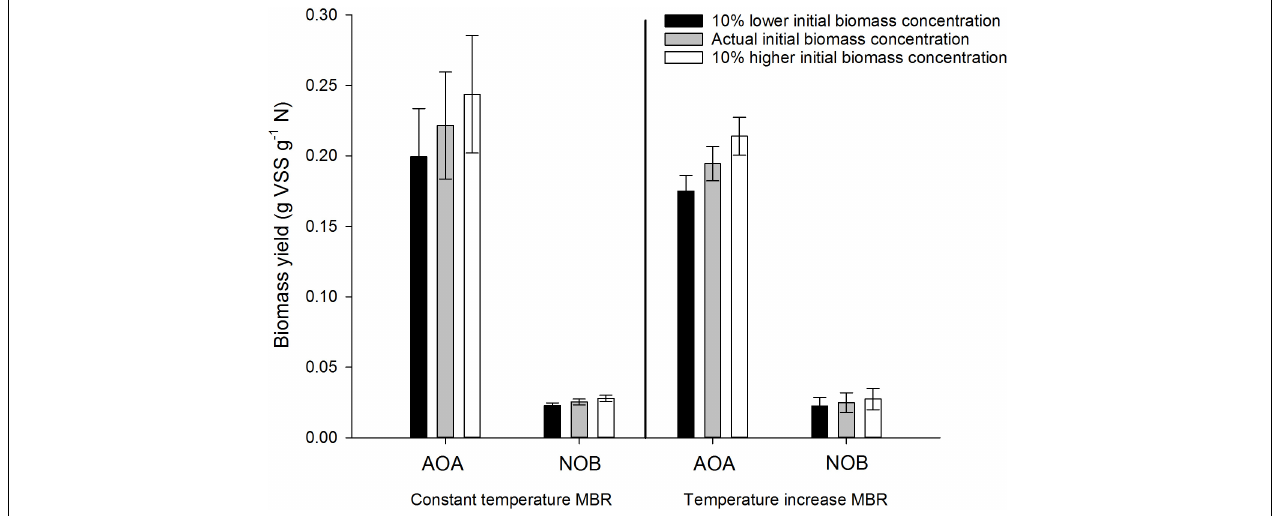
FIGURE 8 | Sensitivity analysis of the obtained biomass yield for AOA and NOB in the constant temperature and temperature increase MBR in three different scenarios: the actual initial biomass concentration, a 10% higher initial biomass concentration and a 10% lower initial biomass concentration. Error bars represent the standard deviation of triplicate incubations with the same inoculum (technical replicates).